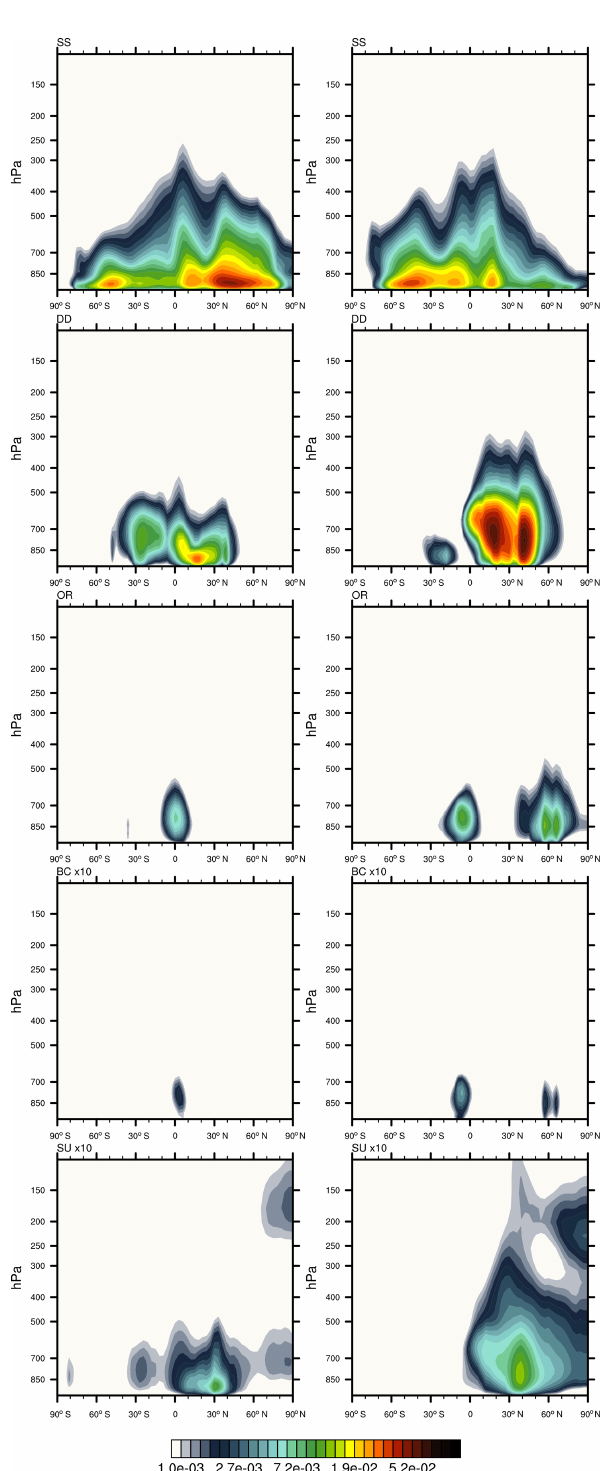
Figure 2. Zonal-mean layer-integrated mass profiles (in grams per square metre), weighted by the total integrated mass at every grid point. Monthly average for January (left) and July (right). Notice that black carbon and sulfate values have been multiplied by 10 for better visualisation.